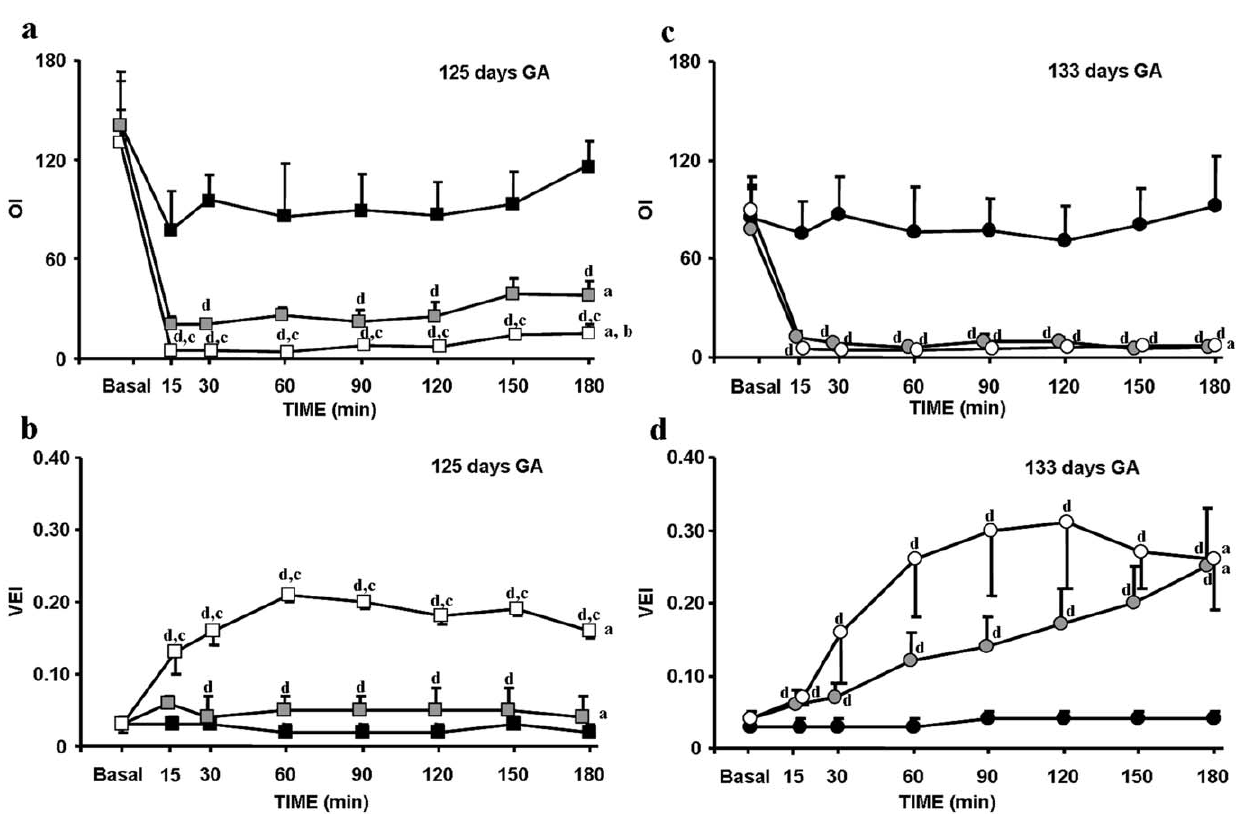
Figure 1. Mean OI and VEI in premature lambs at two gestational ages. Mean OI (a) and mean VEI (b) at 125 days of GA in Control-125d [indicated by black squares]; surfactant, SF-125d [indicated by grey squares] and partial liquid ventilation, PLV-125d [indicated by white squares] groups. Mean OI (c) and mean VEI (d) at 133 days of GA in Control-133d [indicated by black circles]; surfactant, SF-133d [indicated by grey circles]; and partial liquid ventilation, PLV-133d [indicated by white circles] groups. Fetal: indicates the fetal values in both groups, while the lambs are still connected to the placenta. Baseline: shows pre-treatment values before pulmonary treatment. Values are given as mean 6 SEM. Significant differences are indicated by: ( a ) vs. Control group, P , 0.05, two-way ANOVA over all time points; ( b ) vs. SF group, P , 0.05, two-way ANOVA over all time point; ( c ) vs. SF group, P , 0.05, one-way ANOVA at each time point; and ( d ) vs. Control group, P , 0.05, one-way ANOVA at each time point.